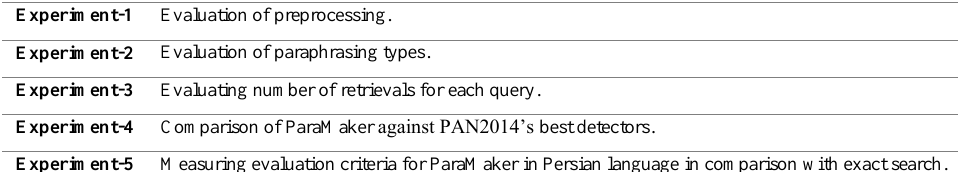
Evaluation of preprocessing. Experiment-1 Evaluation of paraphrasing types. Experiment-2 Evaluating number of retrievals for each query. Experiment-3